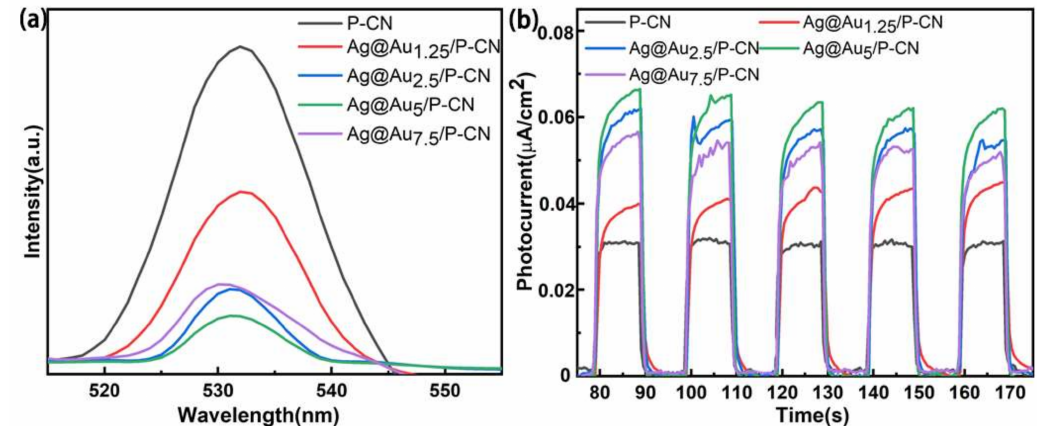
Figure 5. ( a ) The hydrogen production of P–CN and Ag@Au 1.25 /P–CN, Ag@Au 2.5 /P–CN, Ag@Au 5 /P–CN, Ag@Au 7.5 /P– CN and ( b ) Cycle stability test of the Ag@Au 5 /P–CN.